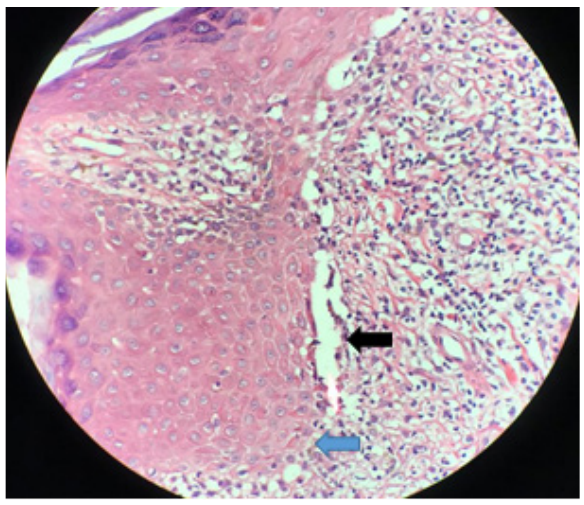
Figure 2. Presence of cleft between epithelium and basement membrane (Max-Joseph space) (black arrow), and hydropic degeneration of basal cells (blue arrow) in cutaneous LP (magnification ×400). Note . LP: Lichen planus.